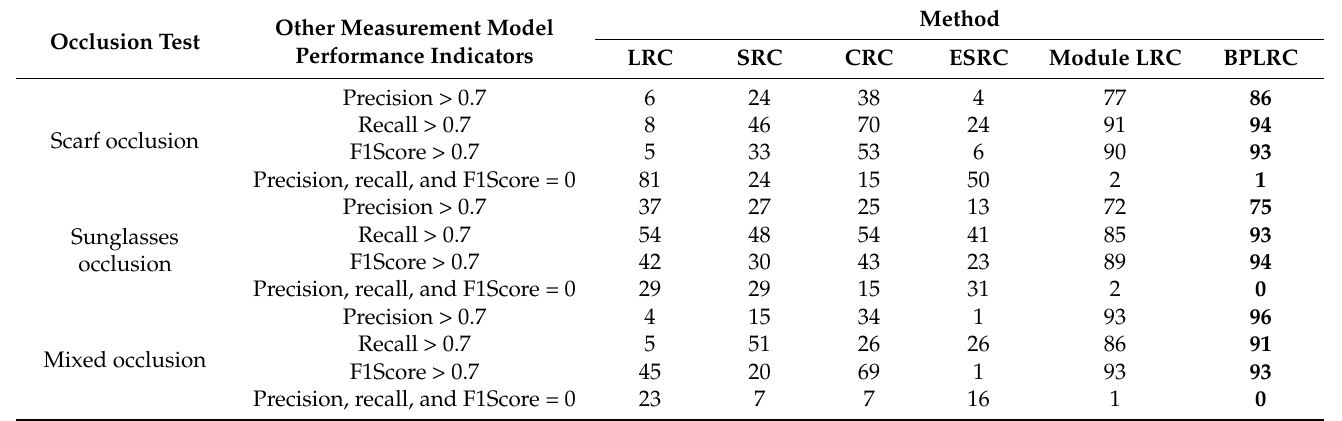
Table 10. The number of categories that identified performance indicators to an extent greater than 0.7 or single categories that were wrongly identified from AR datasets for different methods.